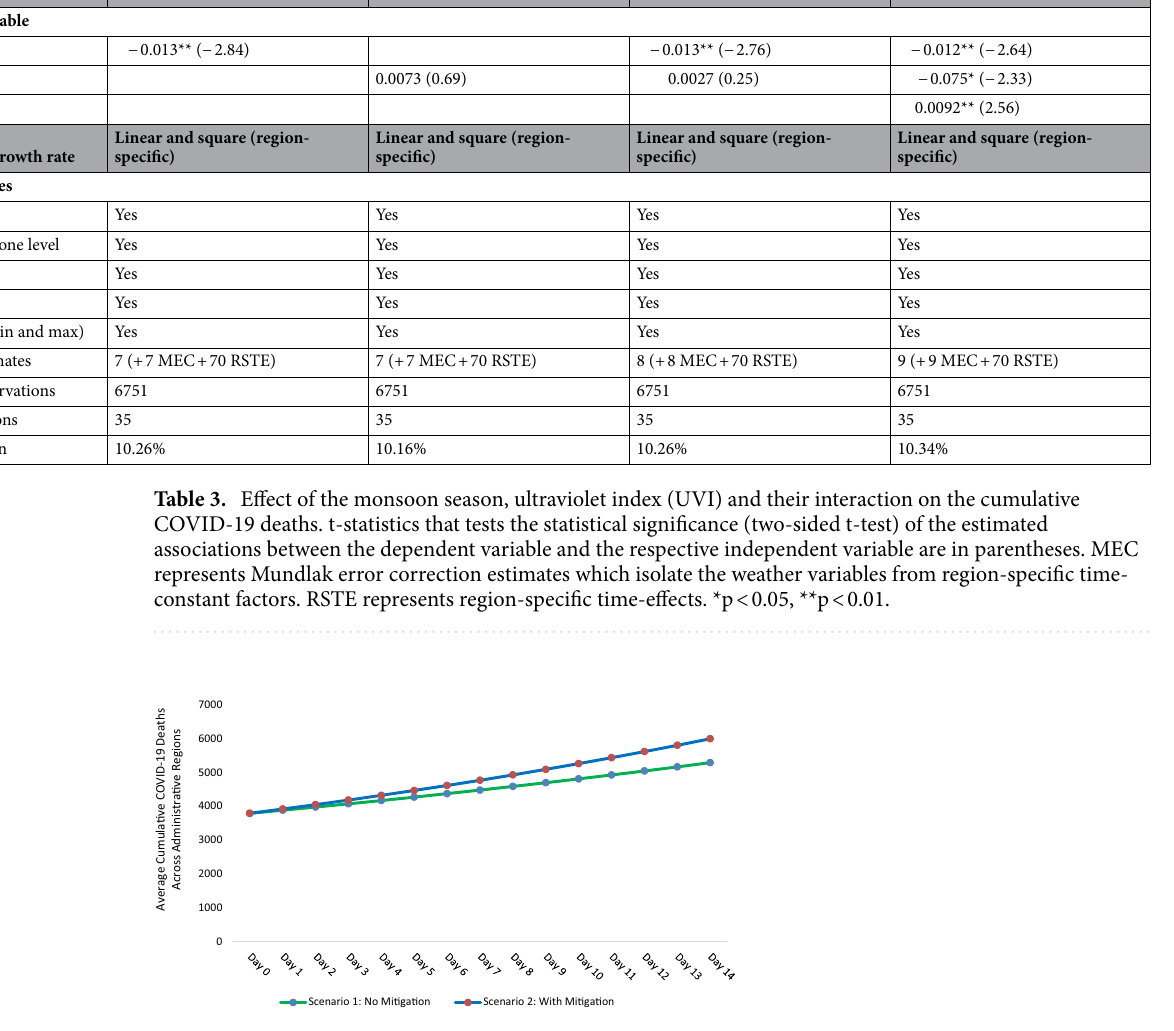
Figure 2. Comparison of scenario 1 (UVB radiation’s protective role is not mitigated by the monsoon season) vs. scenario 2 (UVB radiation’s protective role is mitigated by the monsoon